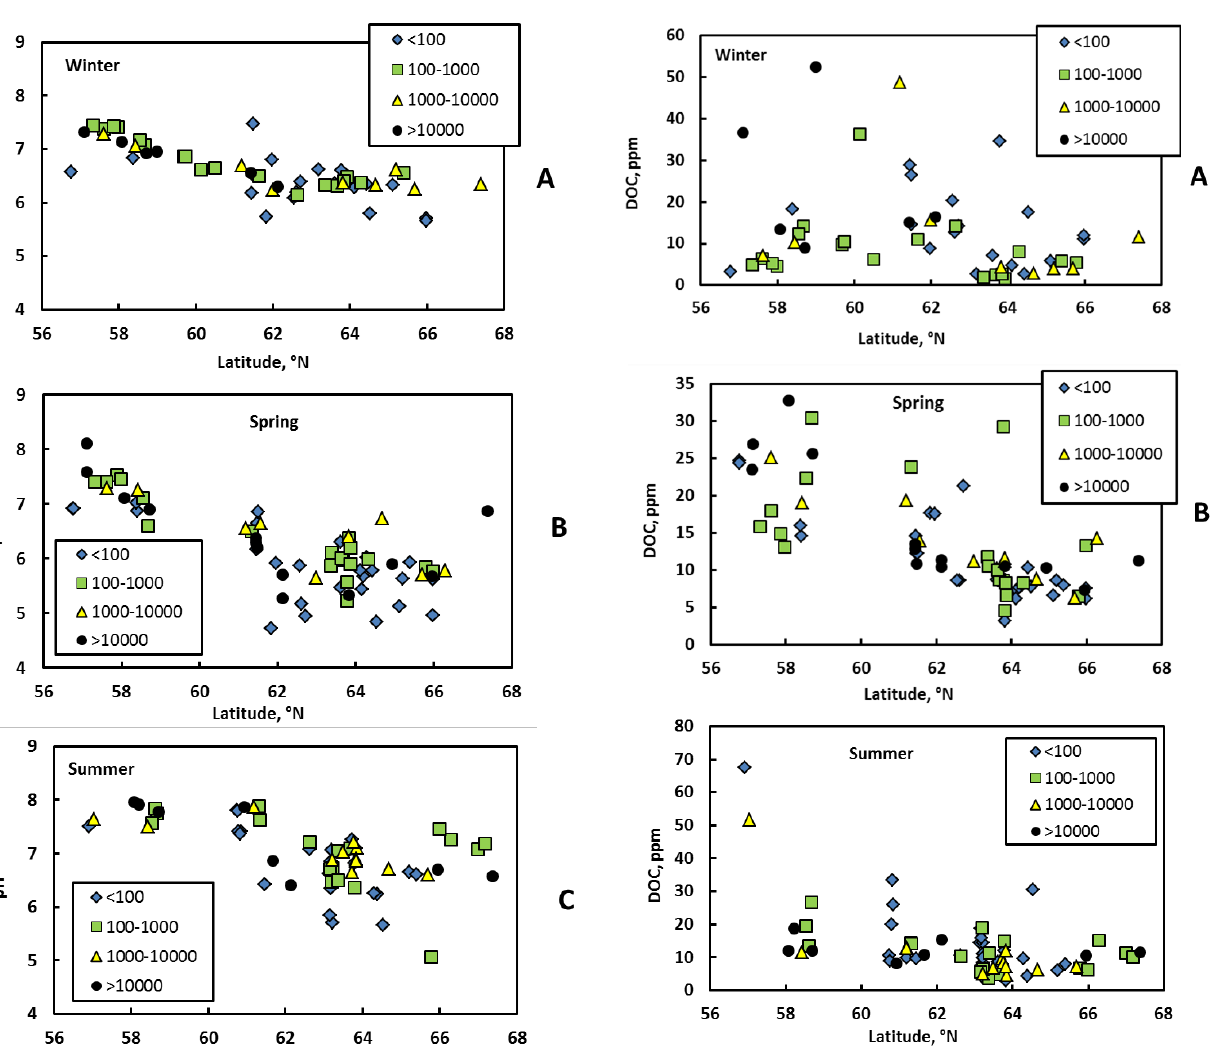
Figure 2. Decrease in river water pH with the increase in the latitude during winter (a) , spring (b) and summer (c) . The spring acid pulse is seen only in permafrost-affected rivers north of 62 ◦ N (b) , and the scatter of the values is maximal during summer (c) . The vari- ability among different watershed sizes is smaller than that between the seasons and within the latitude gradient. Diamonds, squares, tri- angles and circles represent watersheds of size < 100, 100 to 1000, 1000 to 10000, and > 10000km 2 , respectively.